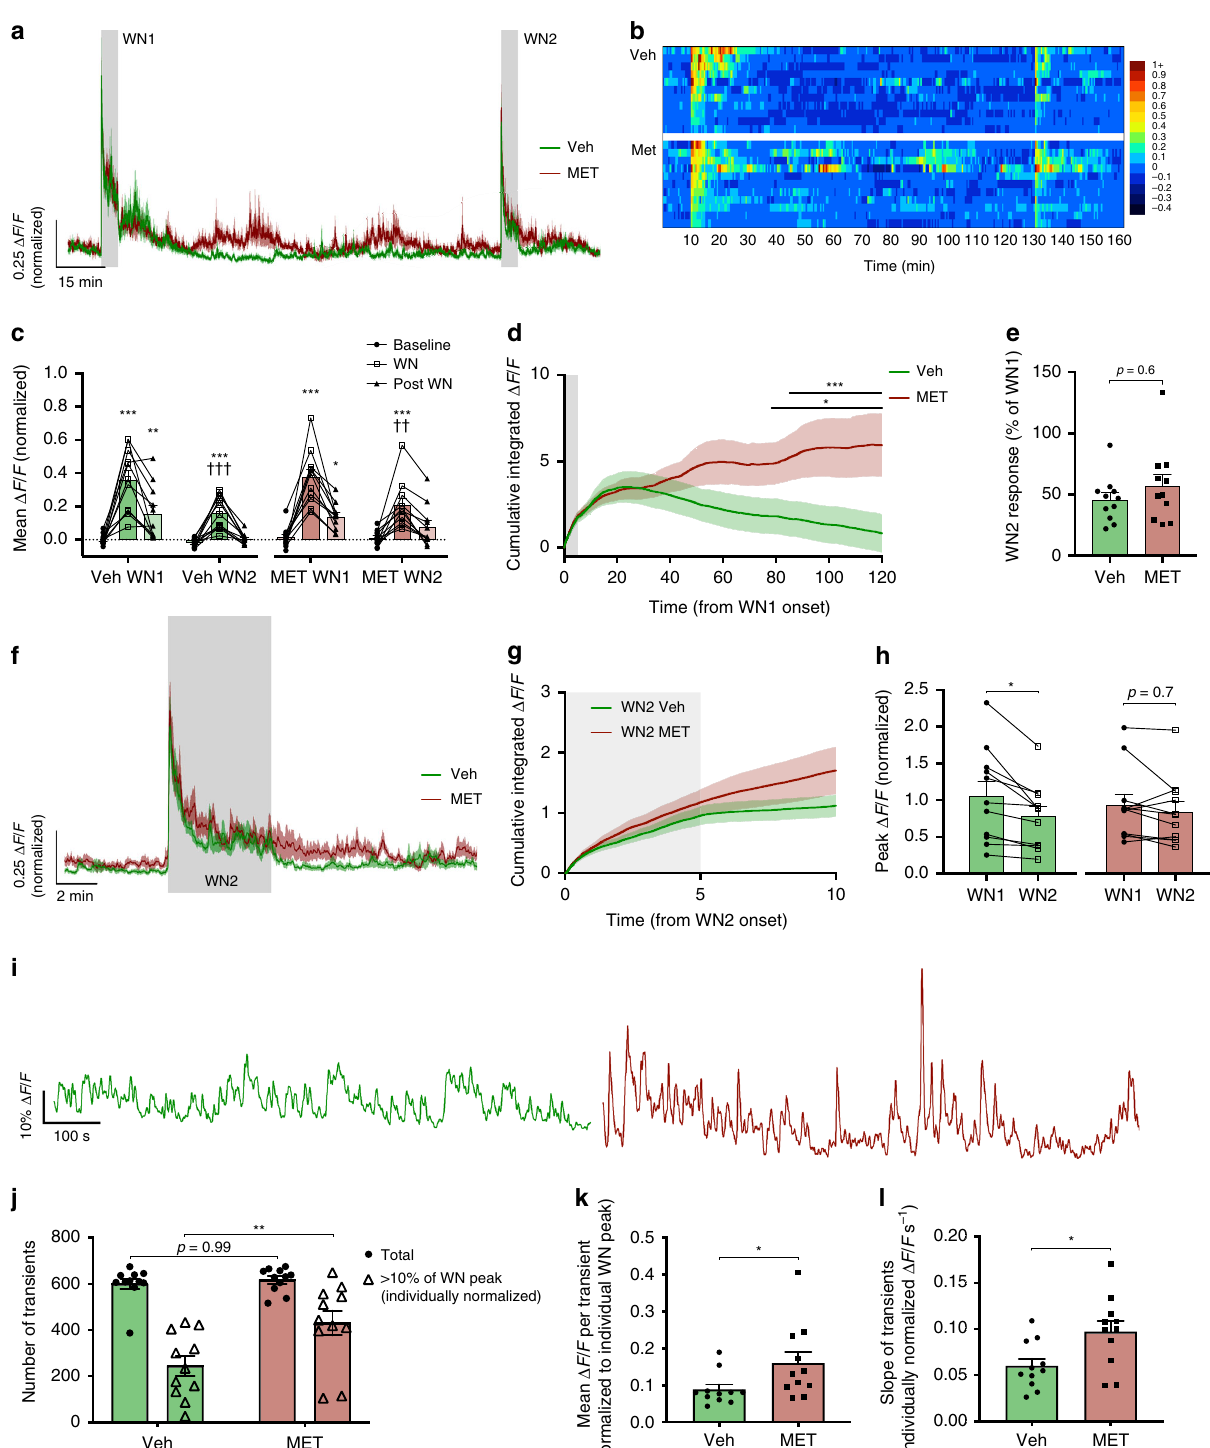
levels. Overall in the metyrapone-treated mice, the mean cumulative CRH neural activity remained elevated (Veh vs. MET cumulative Δ F / F , p < 0.05 from 78 min post WN1 onset, RM two-way ANOVA; Fig. 3d). Despite these differences in tonic activity, a strong adaptive suppression of CRH neuron activity was observed in both groups in response to WN2 (mean CRH activity during 5 min WN2: NATURE COMMUNICATIONS| (2019) 10:5696